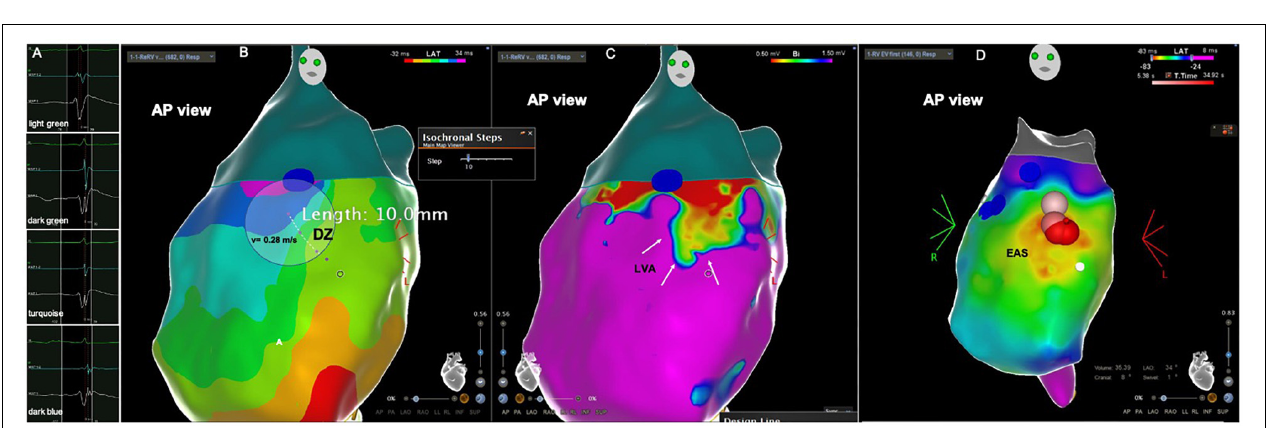
FIGURE 6 | Patient from the PVC group with DZ at a LVA and the earliest activation site located in that zone. (A) Intracardiac electrograms corresponding to the respective isochrones presented in the isochronal map. (B) RVOT isochronal map in sinus rhythm with DZ in the RVOT free wall. (C) voltage map in sinus rhythm with LVA in the RVOT free wall. (D) Activation map during PVC showing the EAS at the DZ and LVA. Red and pink balls corresponding to radiofrequency application points. DZ, deceleration zone; EAS, earliest activation site; LVA, low voltage area; PVC, premature ventricular contractions; RVOT, right ventricular outflow